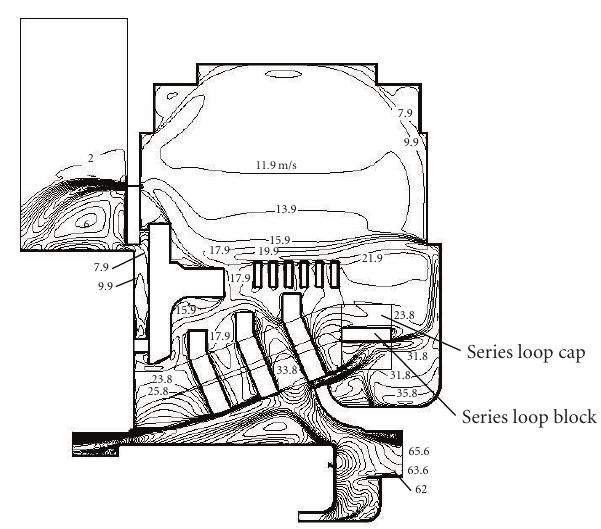
Figure 4: Velocity contours in the generator end-winding region.